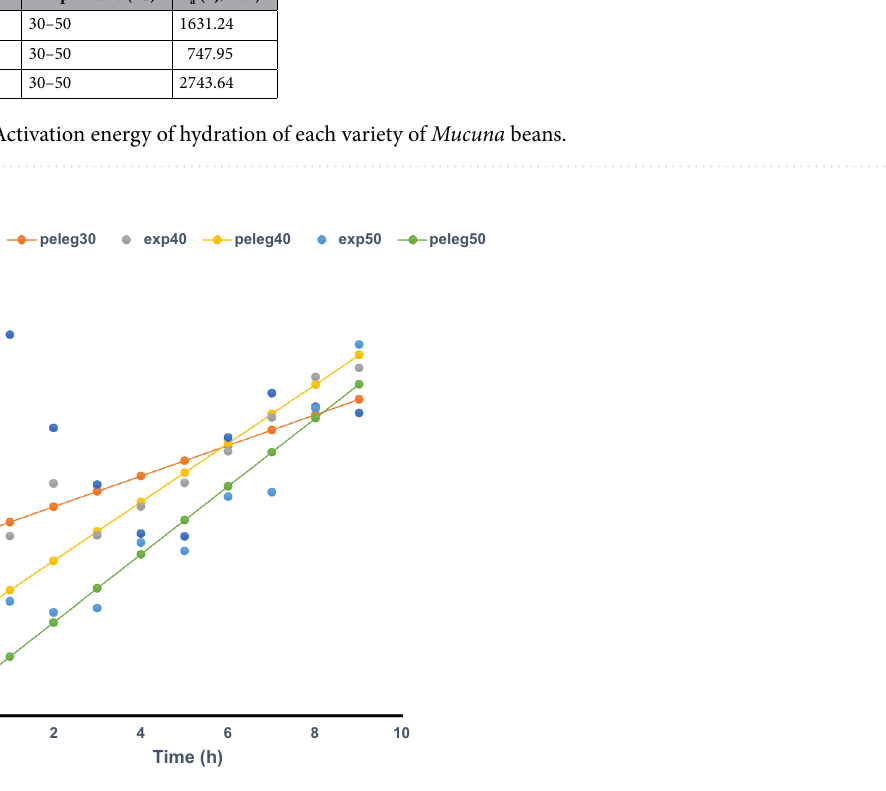
Figure 1. Experimental and Peleg (predicted) water uptake of Mucuna pruriens at different